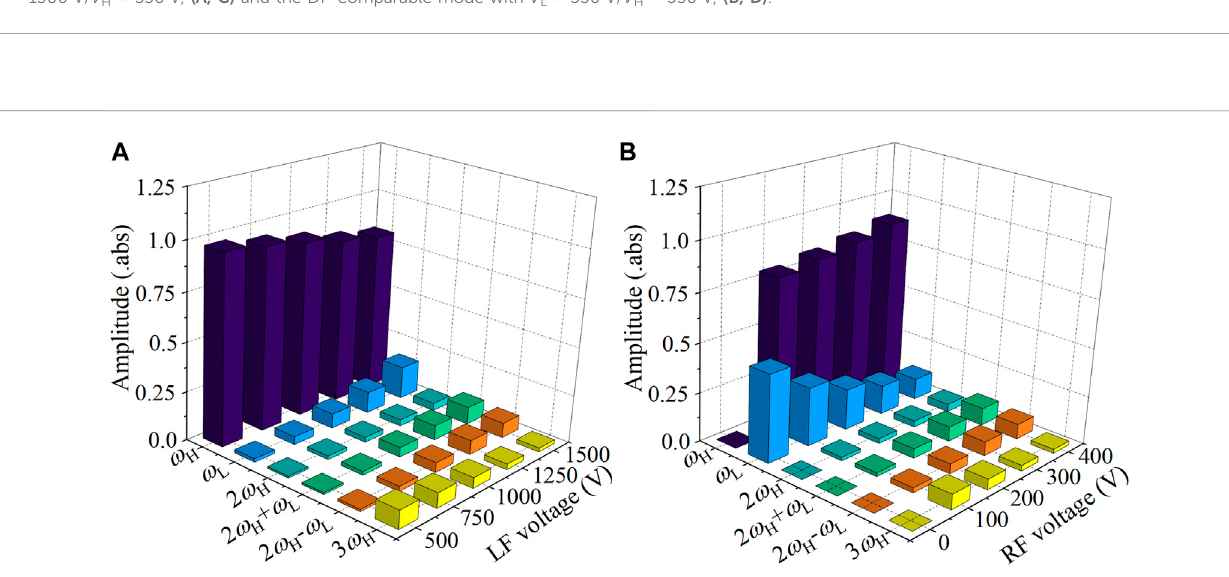
FIGURE 10 FFT components of the fundamentals (LF and RF), the second harmonic with their sum and beat, and the third harmonics in (A) the LF-dominant mode and (B) the DF-comparable